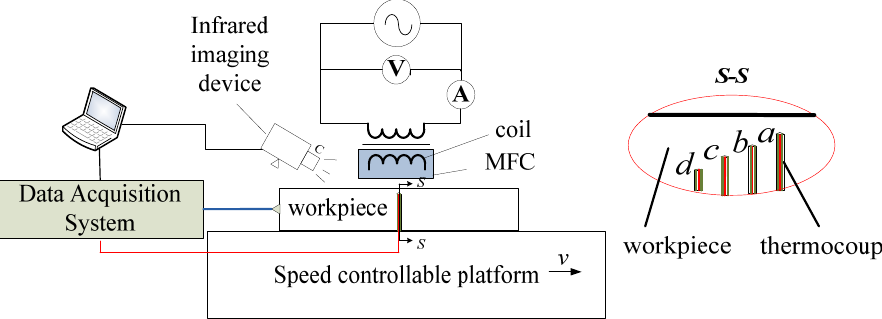
Figure 9. Experiment apparatus of the planar moving induction heating.